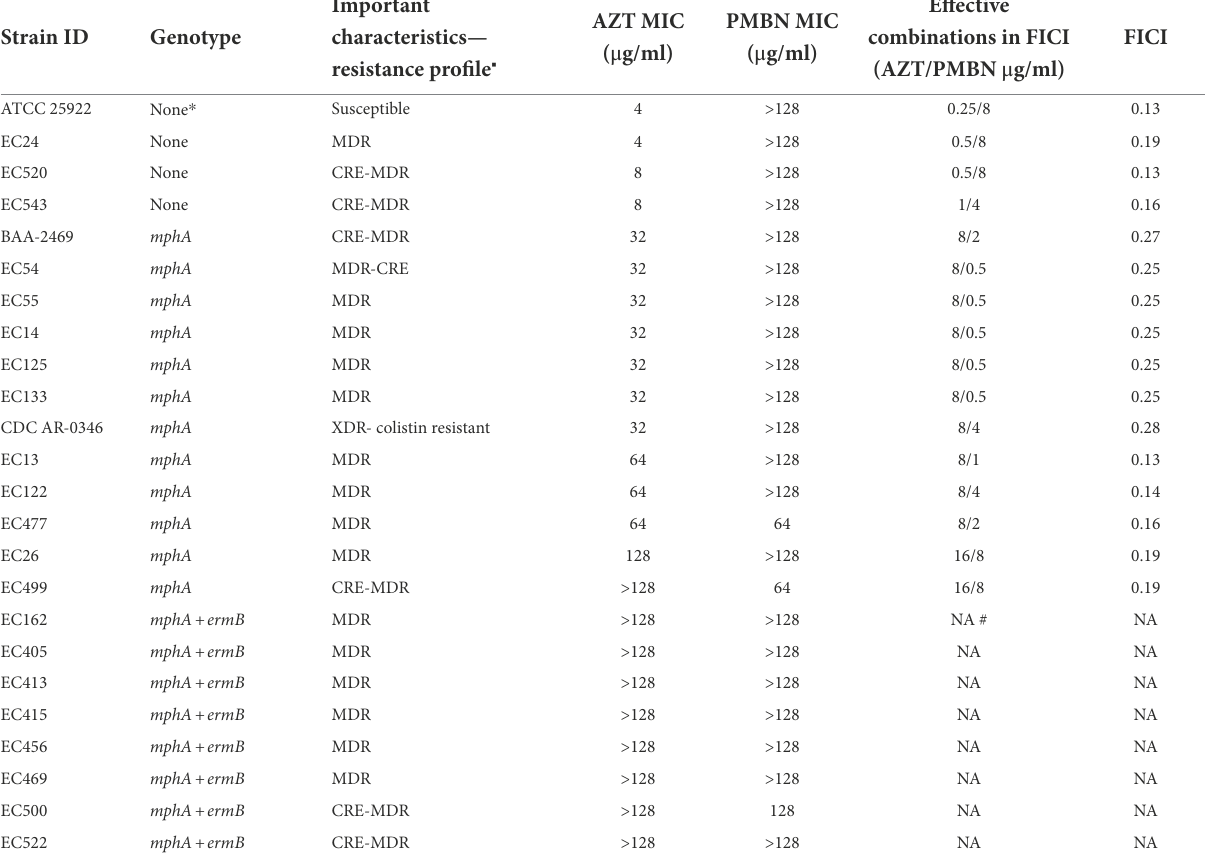
Strain ID Genotype